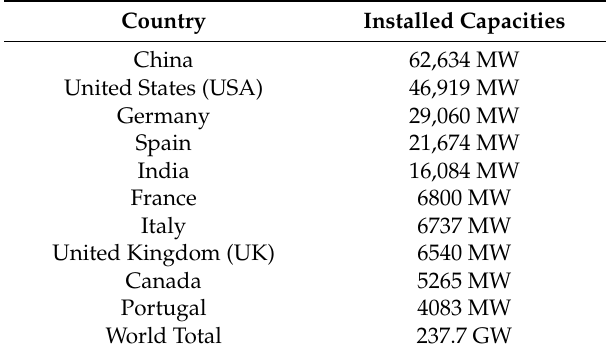
Table 10. Countries with top 10 wind power capacities.